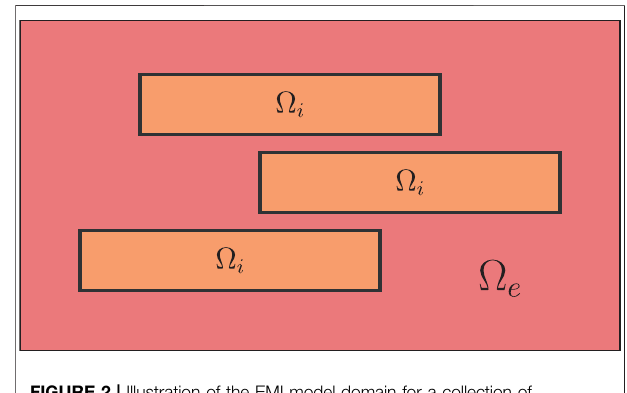
Frontiers in Physics |